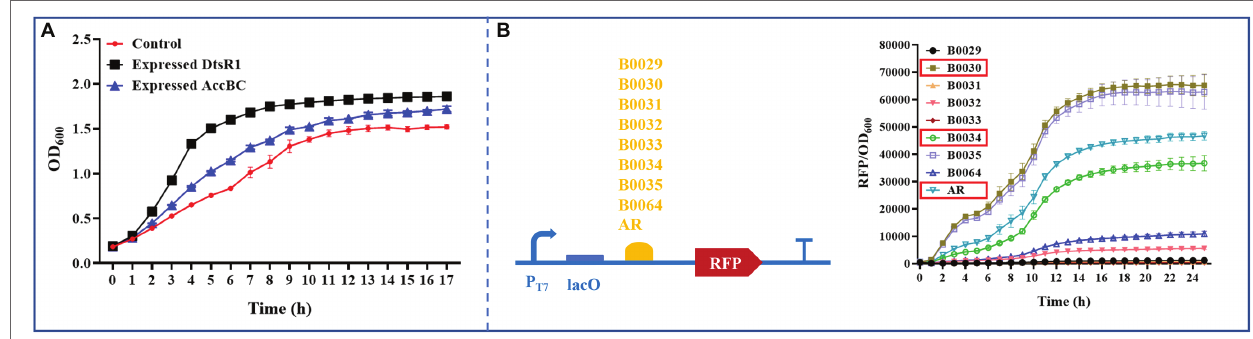
FIGURE 3 | Analyzing the influence of overexpressed DtsR1 or AccBC on cell growth and characterizing RBS strength in Escherichia coli BL21 (DE3). (A) DtsR1 and AccBC were expressed in strains Expressed DtsR1 and Expressed AccBC, respectively. Escherichia coli was cultivated in a 24-well microassay plate containing 2 ml of medium at 30 ° C; 0.2 mM IPTG was added upon inoculation. Strain containing empty vector as the control. (B) RBSs of various strengths were characterized and screened to regulate AccBC and DtsR1 expression through real-time monitoring of the fluorescence intensity of RFP using a Multi-Detection Microplate Reader. RBS strength was calculated with the ratio of RFP to OD 600 . All results were calculated with three ( n = 3) independent